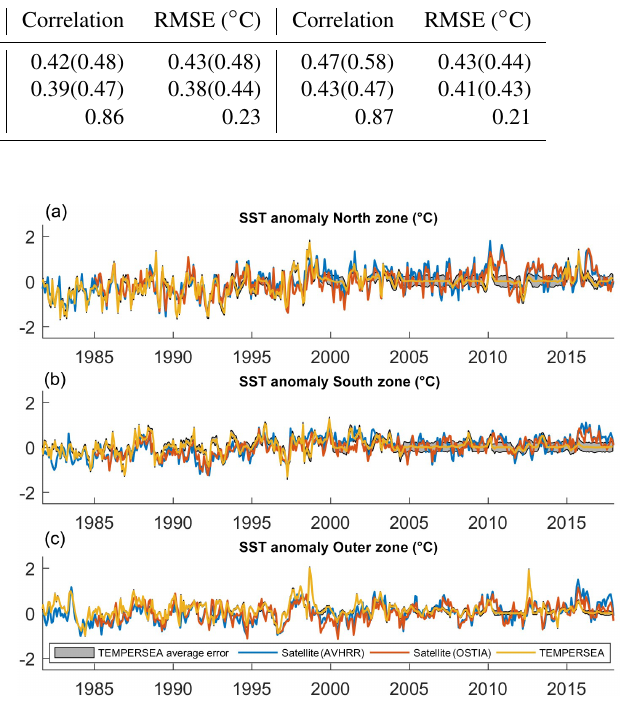
Figure 10. Monthly anomalies of regionally averaged SST in the three zones, North zone (a) , South zone (b) and Outer zone (c) . The three datasets are shown for the common period: TEMPERSEA (yellow line), AVHRR (blue line) and OSTIA (red line). The grey patch represents the uncertainties estimated for the TEMPERSEA